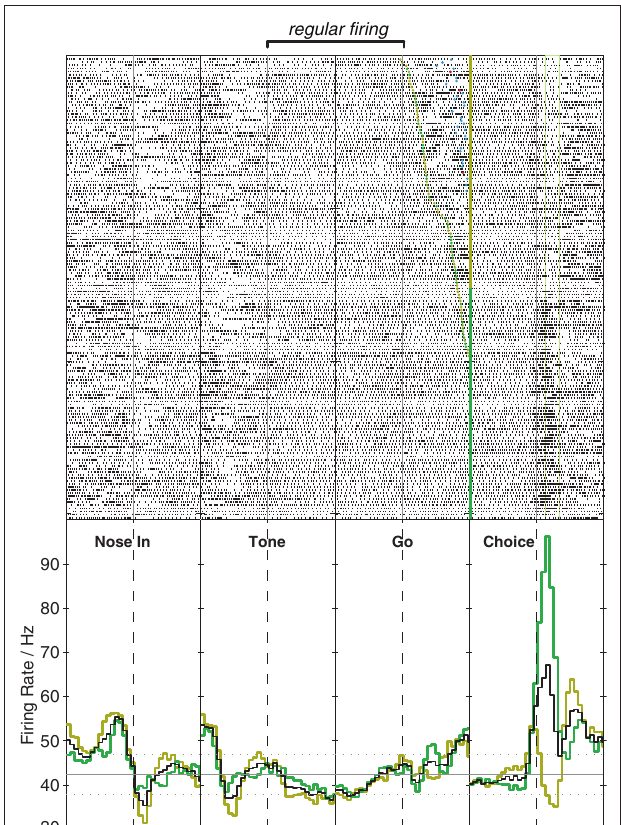
FiGure 1 | Stabilization of FSi firing pattern with action programming. This example shows activity of a single striatal FSI during performance of an instructed left/right choice task (Gage et al., 2010). Upper panels show raster plots (151 trials total), lower panels show peri-event histograms of firing rate (time range: –0.5 to 0.5s in each case). The rat begins the trial by inserting his nose into an illuminated port (Nose In) and waits for an instruction cue (Tone) that indicates whether a subsequent left or right movement will be rewarded, provided the rat waits for a second cue (Go) before initiating his movement (Choice). For the raster aligned on the Go cue, trials are ordered by reaction time. The FSI shows a sharp increase in firing rate beginning shortly before movement onset, that in this case is stronger for ipsilateral (green) than contralateral movements (gold). The onset of the tone is not associated with a substantial firing rate change, but causes the cell to spike far more regularly until the action is executed (for quantitative analysis, see Lau et